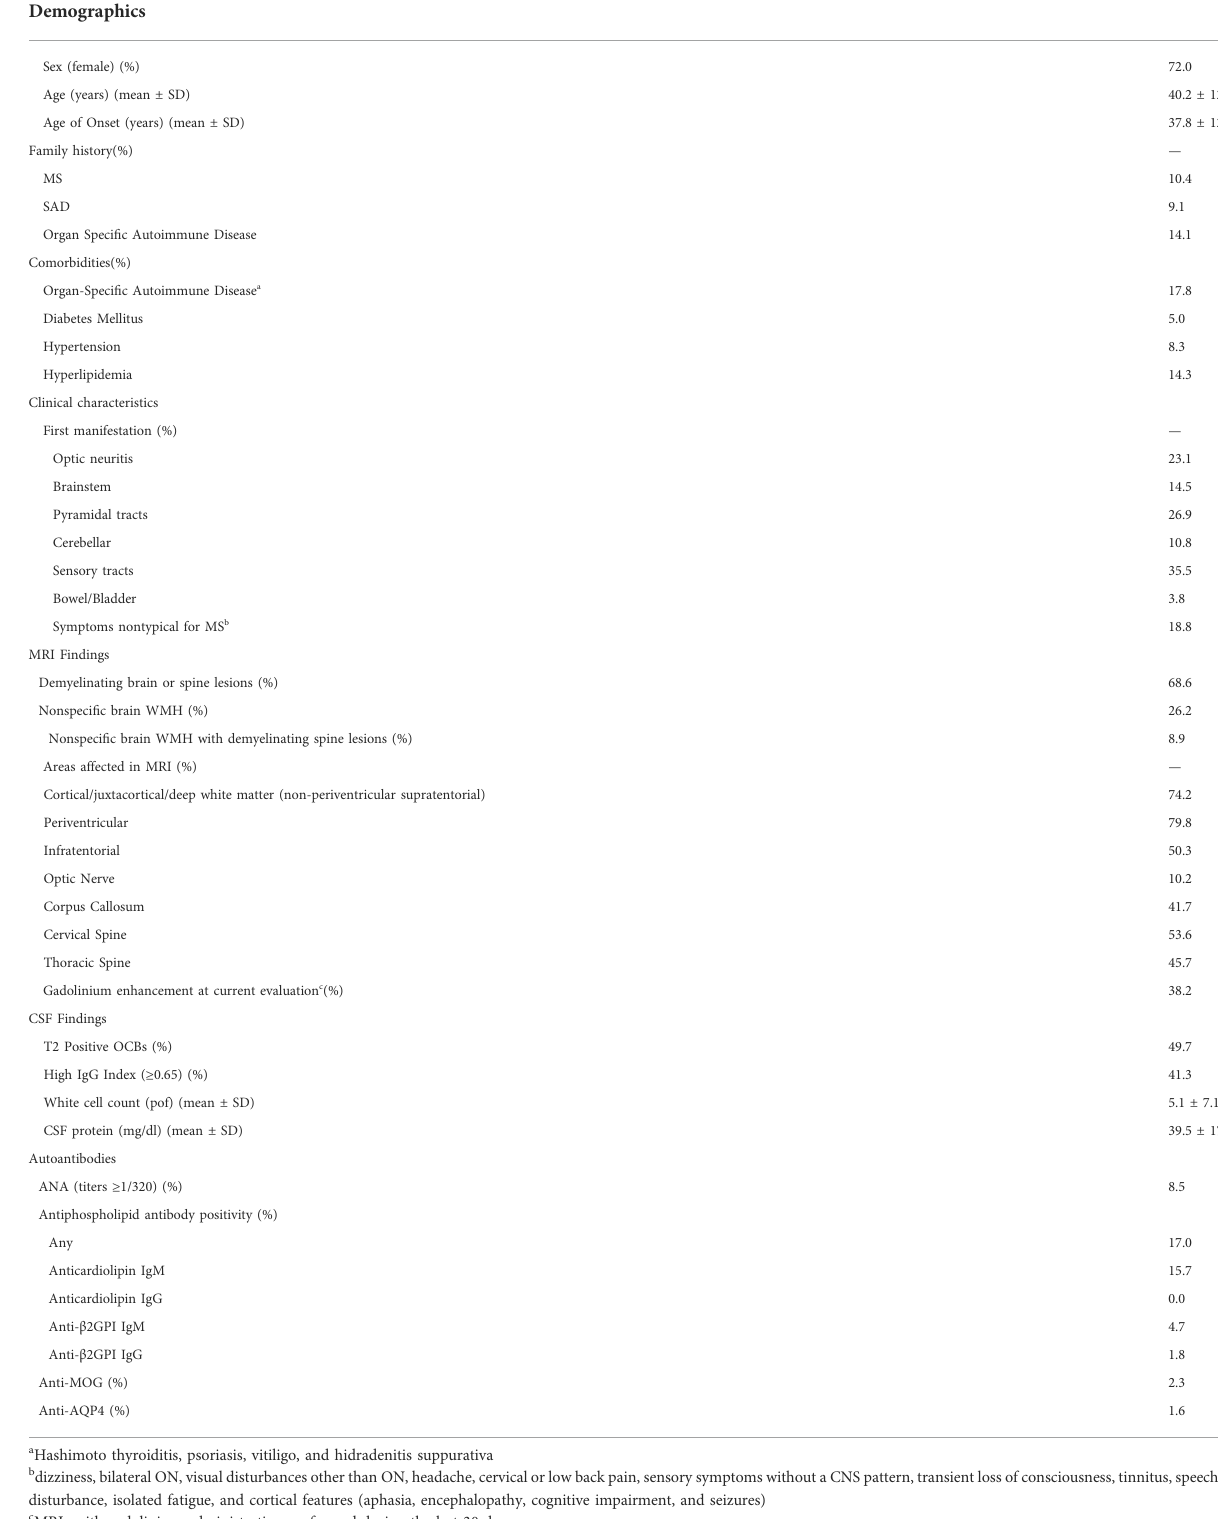
TABLE 1 Descriptive characteristics of the 193 study